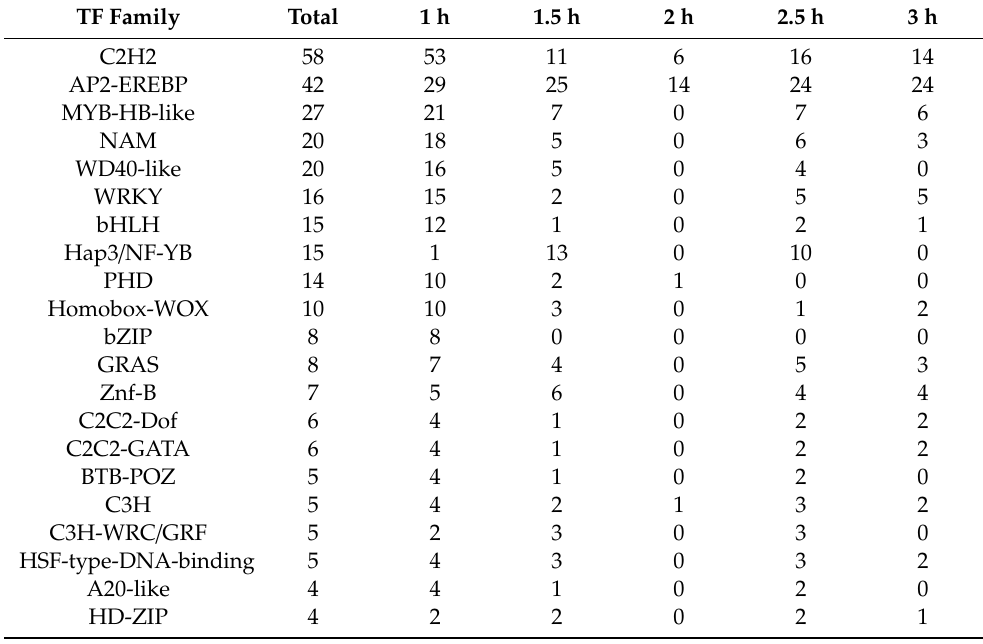
Table A10. Di ff erentially expressed TFs under di ff erent low-temperature stress time